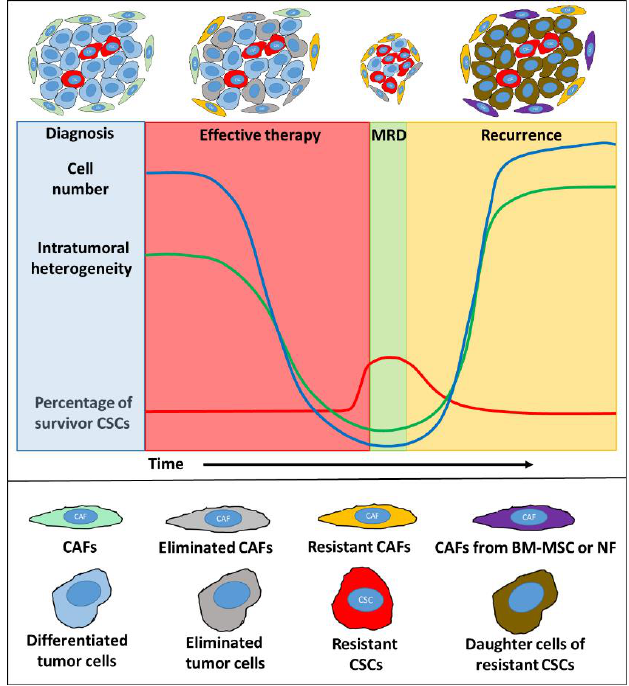
Figure 1. Summary of presumptive changes in carcinoma-associated fibroblast (CAF) populations, intratumoral heterogeneity, numbers of cancer cells, and percentages of survivor cancer stem cells (CSCs) during therapy and recurrence. In the course of chemotherapy, the majority of cancer cells (blue) are eliminated (grey). In parallel, the percentage of CSCs (red) may increase in minimal residual disease (MRD) compared to the gross tumor mass. During recurrence, daughter cells of the resistant CSCs can repopulate (brown) the tumor. The original CAF population (green) is partially eliminated (grey) by the therapy. Resistant (yellow) and newly formed CAFs may have dedi ff erentiated from normal fibroblasts (NFs) and from bone-marrow-derived mesenchymal stem cells (BM-MSCs)